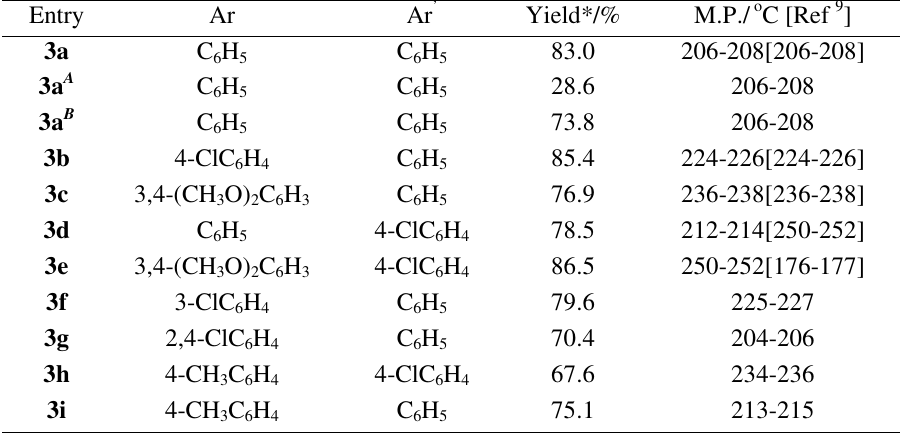
Table 2 The Substituted 5-Oxo-1,2,3,4,5,6,7,8-Octahydroquinoline Derivatives Synthesized by 5,5-Dimethyl-1,3-Cyclohexane-Dione, Ammonium Acetate and